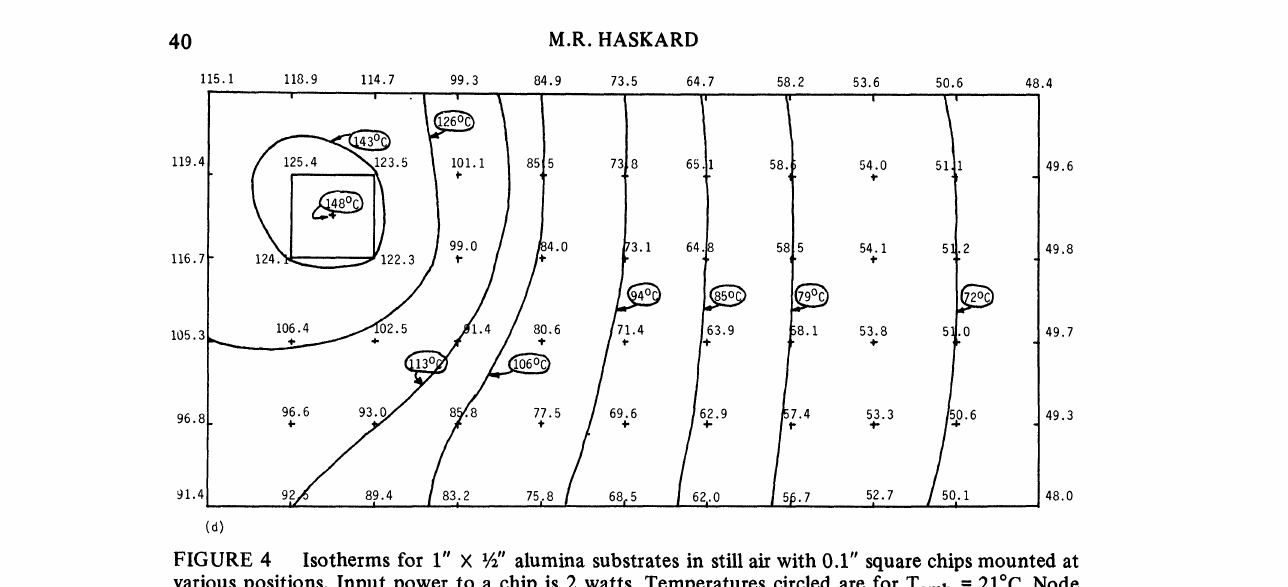
FIGURE 4 Isotherms for 1" X 1/2" alumina substrates in still air with 0.1" square chips mounted at various positions. Input power to a chip is 2 watts. Temperatures circled are for Tam b 21C. Node temperatures are degrees Celsius above ambient.